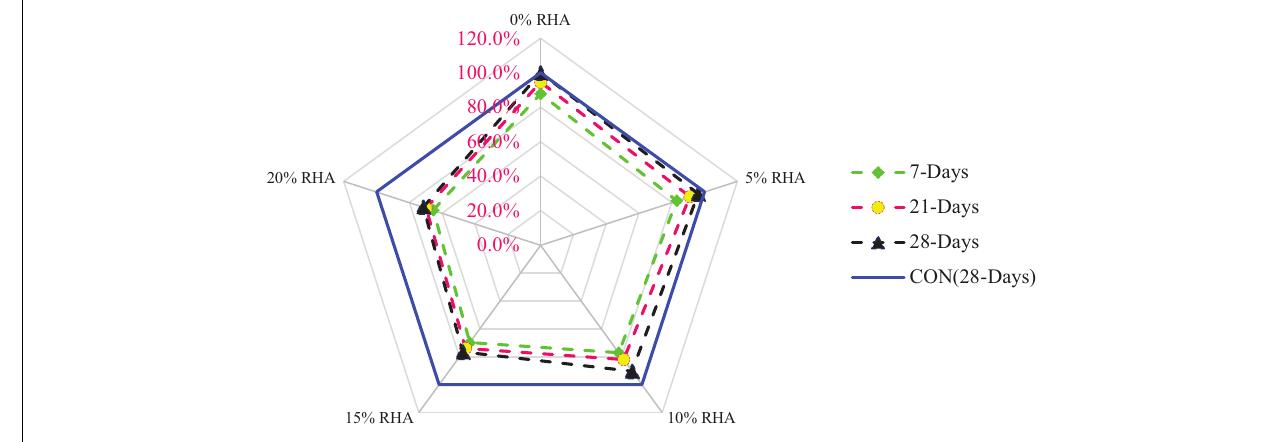
FIGURE 3 | Relative analysis compressive strength (without steel fibers and superplasticizer).